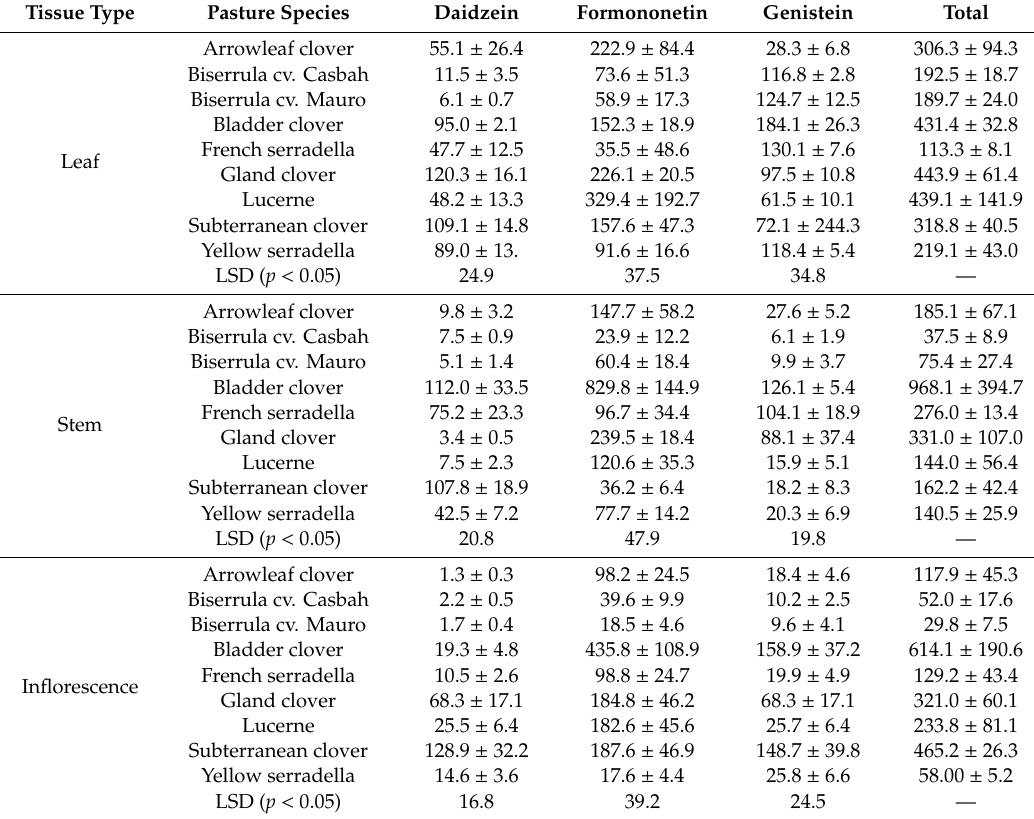
Table 2. The concentration of daidzein, formononetin and genistein (mg kg − 1 ) in annual pasture legume species at physiological maturity,